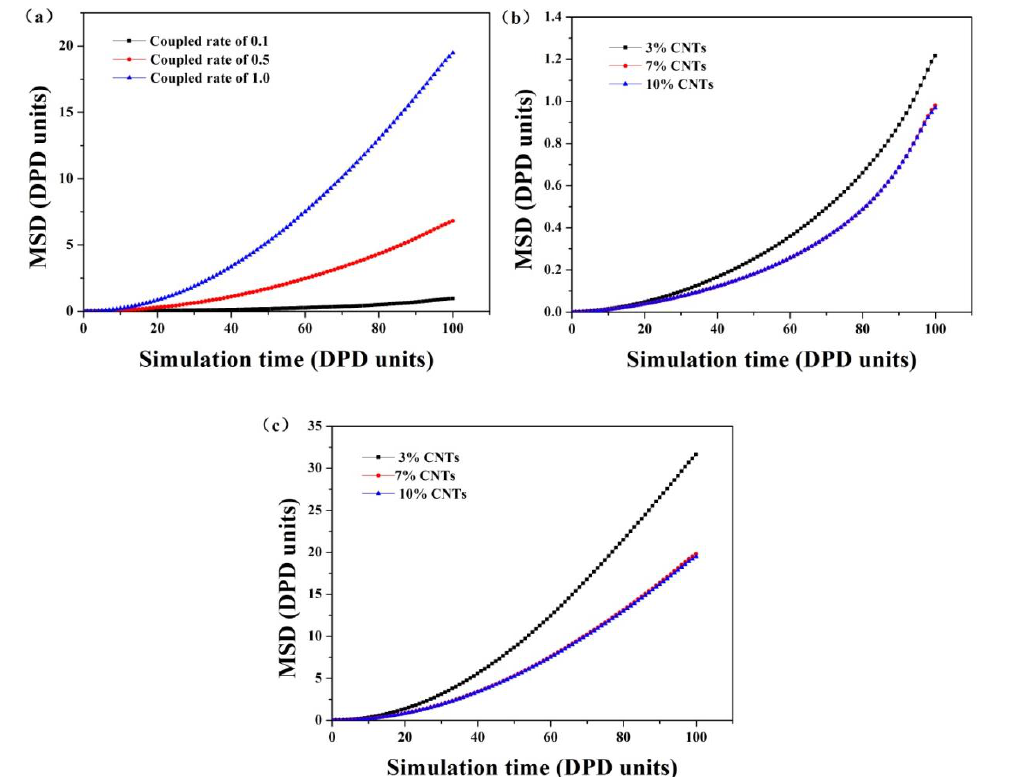
Figure 5. Figure 5. The MSD plots of CNTs in CNTs/UHMWPE composites related to: ( a ) different extensional- extensional-shear coupled rates ( b , c ) CNTs concentrations, with coupled rate of 0.1 and 1.0, respectively. Polymers 2018 , 10 , x FOR PEER REVIEW shear coupled rates ( b ) and ( c ) CNTs concentrations, with coupled rate of 0.1 and 1.0, respectively.